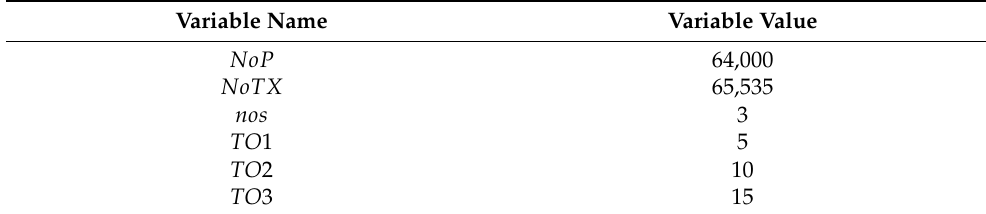
Table 2. Variable values in the simulation